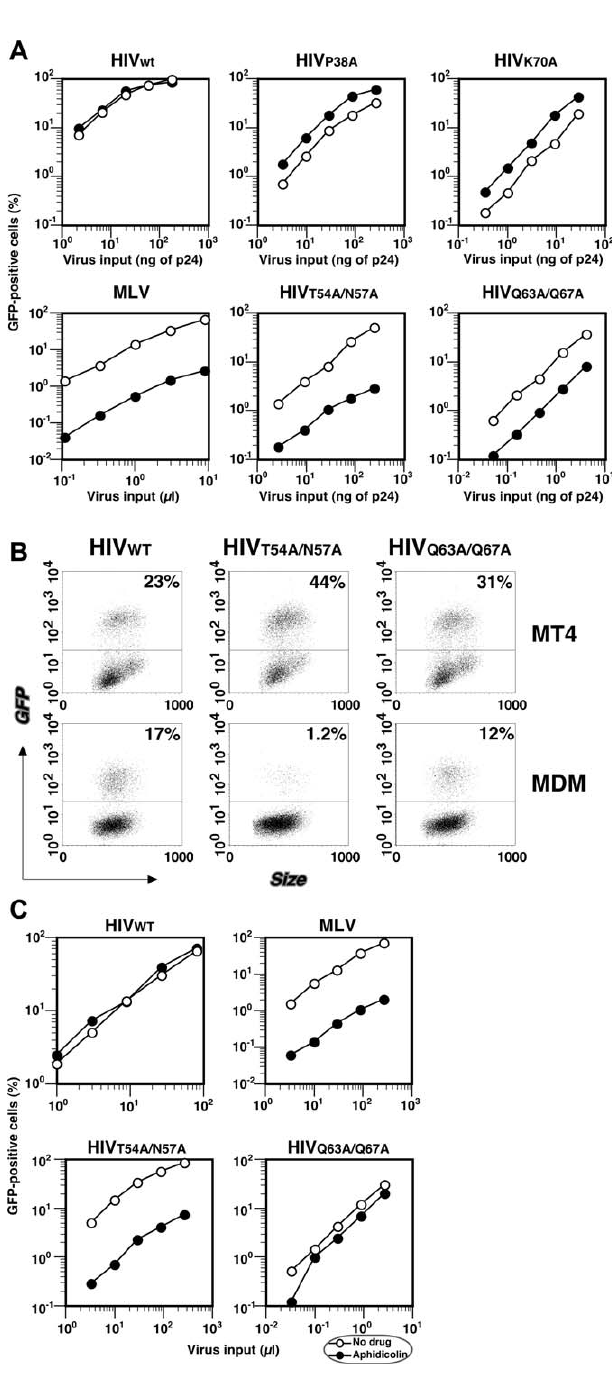
Figure 1. HIV CA Mutants Require Cell Division for Efficient Infection (A) Dose-independent restriction of several CA mutants in nondividing cells. Nondividing cells were prepared by treatment of HeLa cells with aphidicolin and then infected with increasing amount of GFP-encoding viruses. Virus infectivity was measured by quantifying GFP-positive cells 2 d after infection. WT HIV-1 and MLV were used as controls. Open circles indicate infections with cycling cells and closed circles indicate infections with nondividing cells. (B) Infection of MDMs with HIV-1. The WT strains together with CA mutants T54A/N57A and Q63A/67A were used to infect a human T cell line (MT4: upper panels) or MDMs (lower panels). Ten times more virus was used in MDMs, which are not as permissive as MT4 cells to HIV-1 infection. Expression of GFP, which is encoded by the reporter virus constructs, was examined 2 or 3 d after infection. The % of GFP-positive cells is indicated in the upper half of each flow cytometry panel. The